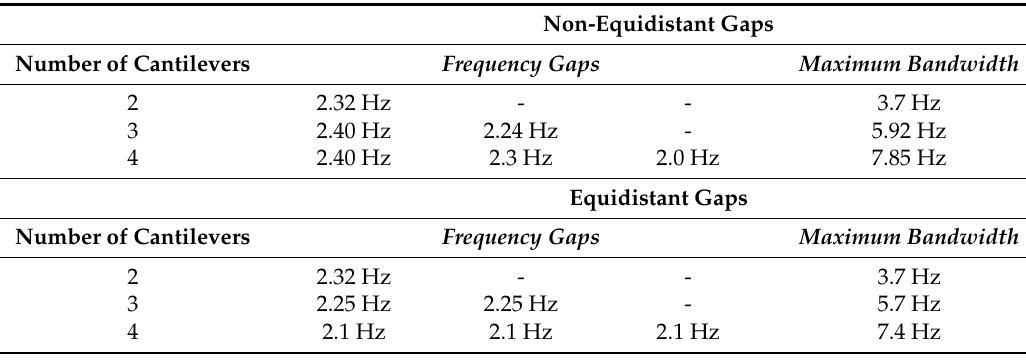
Table 3. Comparison between the theoretical maximum bandwidth with non-equidistant and equidistant gaps between the resonant